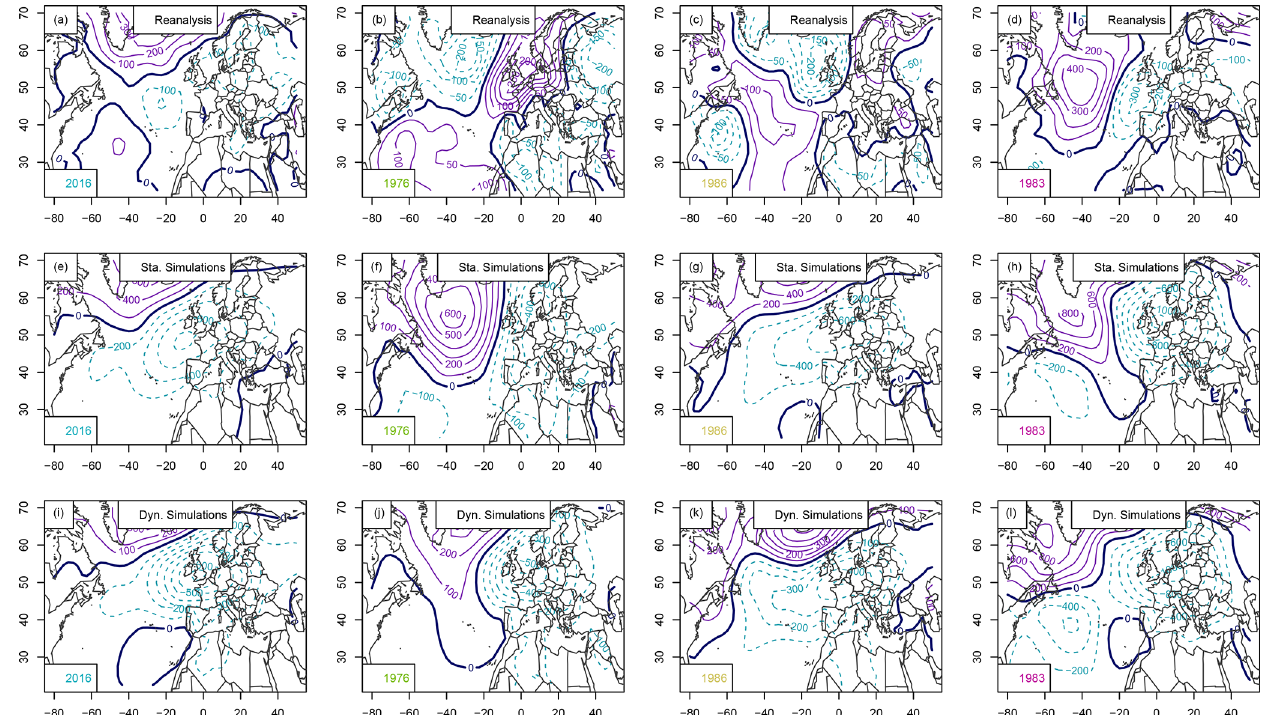
Figure 7. SLP anomaly composites (Pa) for April–July 2016, the driest period, the median (1986), and the wettest period (1983): (a–d) mean SLP from NCEP reanalyses, (e–h) static SWG simulations, (i–l) dynamic SWG simulations. Isolines are shown with 100Pa increments. Positive SLP anomalies are shown with continuous purple isolines, negative anomalies are shown with dashed cyan lines, and the mean SLP isoline is shown with a continuous thick black